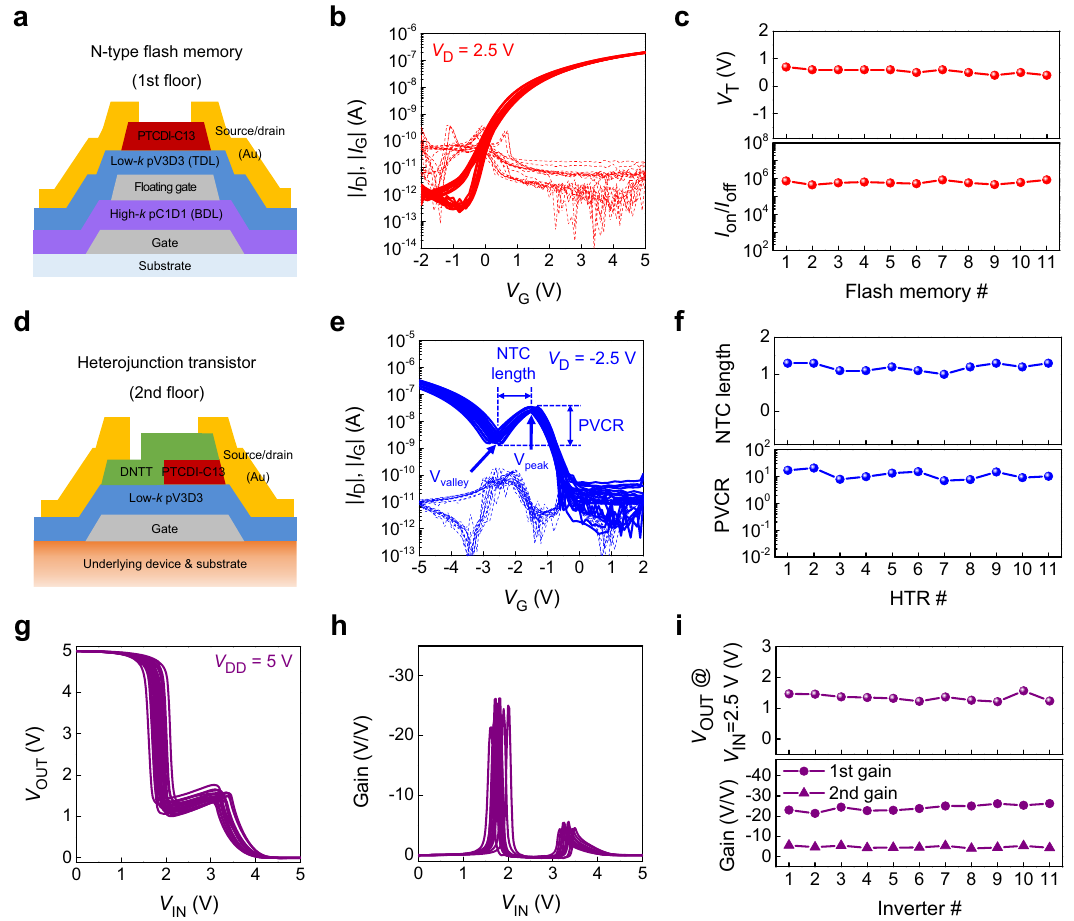
Fig. 3 Device-to-device uniformity. a Schematic illustration of the organic fl ash memory on the fi rst fl oor, b transfer characteristics of the 11 memory devices, and c their threshold voltage ( V T ), on/off current ratio ( I on / I off ) variation. d Schematic illustration of the heterojunction transistor (HTR) on the second fl oor, e transfer characteristics of the 11 HTR devices, and f their negative transconductance (NTC) length, peak-to-valley current ratio (PVCR) variation. g voltage transfer characteristics (VTCs), h DC gain pro fi les, and i intermediate logic value, DC gain variation of the 11 3-dimensional (3D) ternary logic inverter (T-inverter)